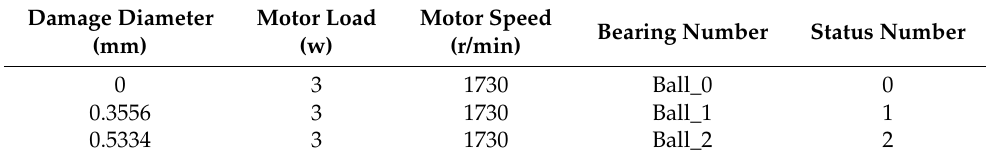
Table 1. Selected types of rolling bearing